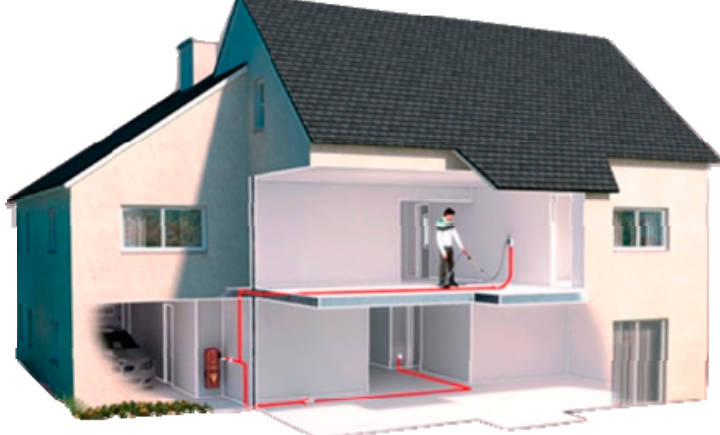
Figure 1. Housing profile upon the central system of vacuum cleaner.